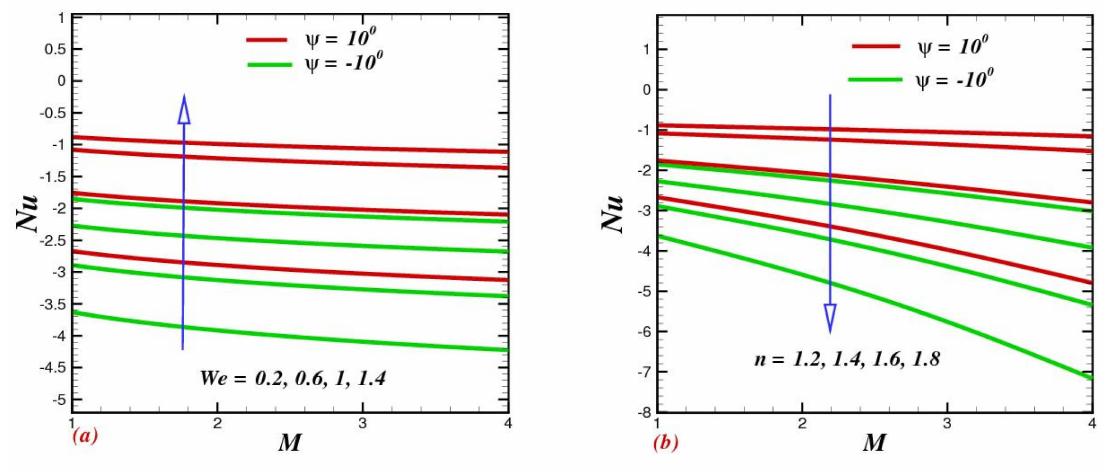
Figure 10. Impact of ( a ) the Weissenberg number We and ( b ) the power-indexed parameter n on the Nusselt number Nu